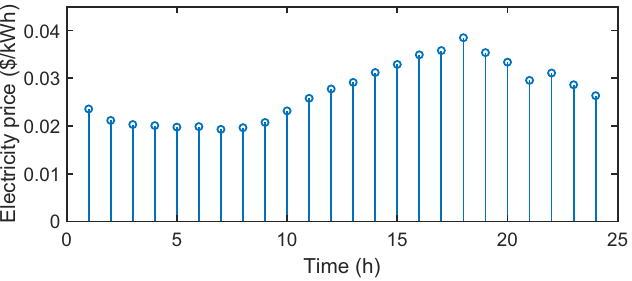
Figure 7. The electricity prices of the electric utility. Table 1. Parameters for the microgrids ( ∀ i ∈ M , ∀ STO ∈ S ).